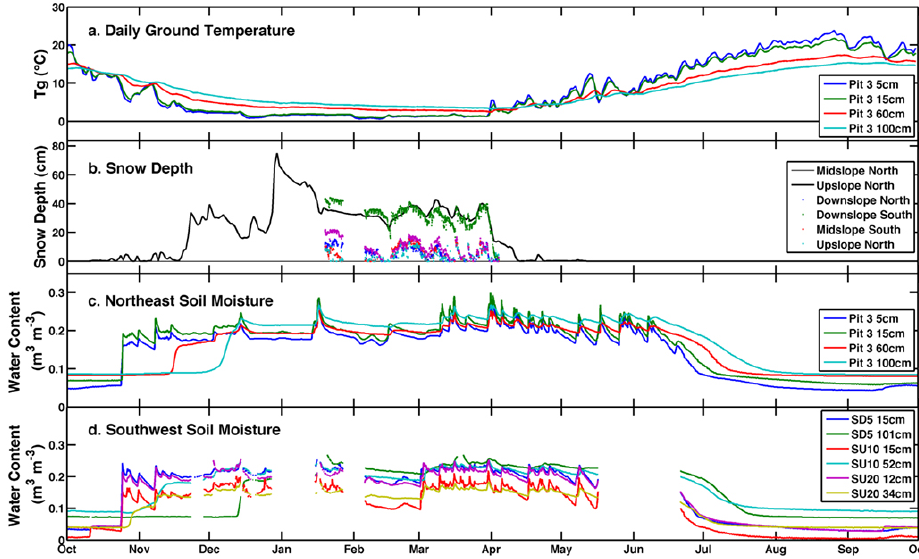
Figure 4. Soil and snow data from the Treeline experimental catchment for WY2011. Daily average soil temperature (a) and moisture (c) from pit 3 on the northeast facing slope, and soil moisture from several pits from the southwest facing slope (d) are presented. Snow depths from six locations are presented in (b)